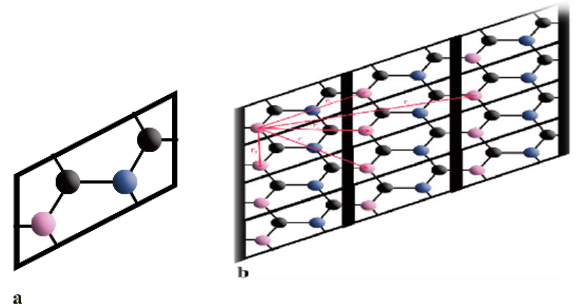
Figure 1. a ) Unit cell of BC 2 N; b ) ultimate Structure of BC 2 N. Figure 1. ( a ) Unit cell of BC 2 N; ( b ) ultimate Structure of BC 2